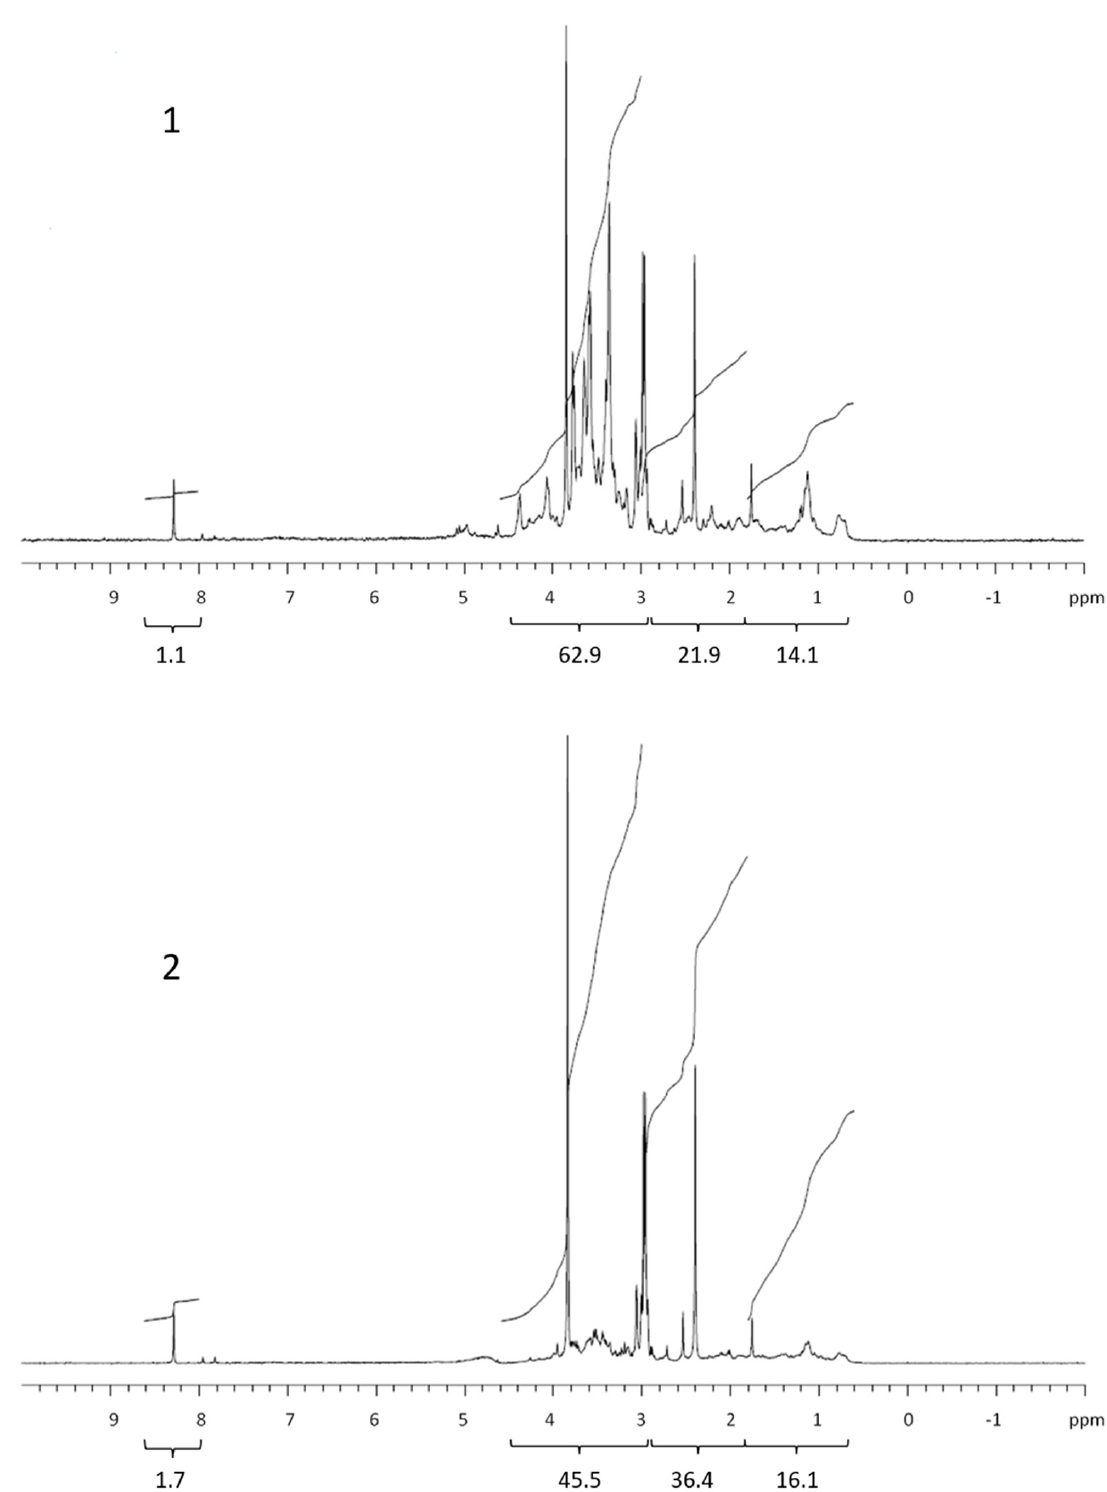
Figure 2. 1 H NMR spectra of retentate ( 1 ) and permeate ( 2 ) isolated from exudate of the diatom Chaetoceros socialis. Values below brackets are integrated values.